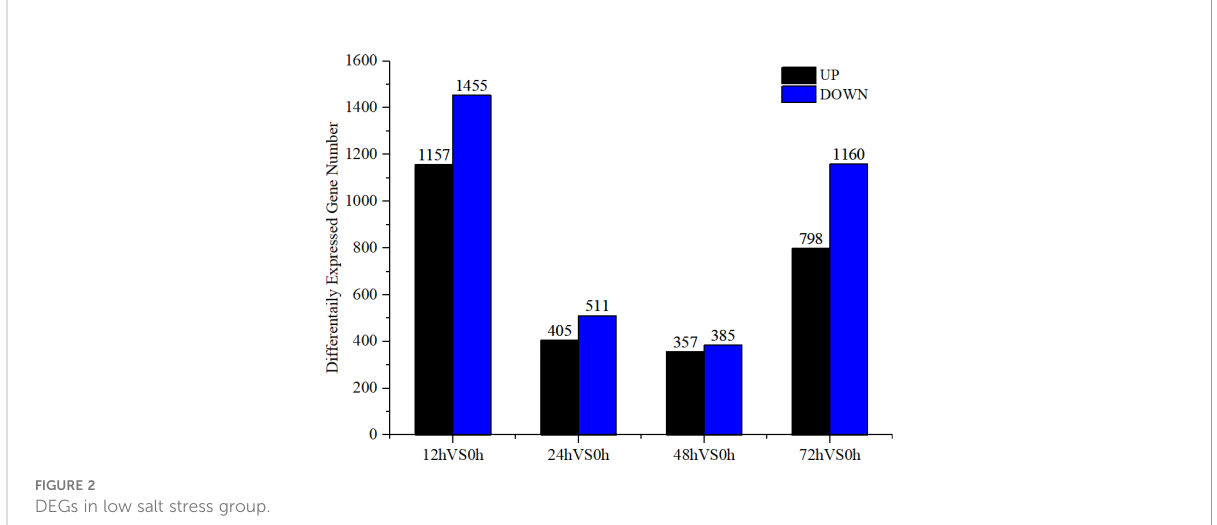
FIGURE 2 DEGs in low salt stress